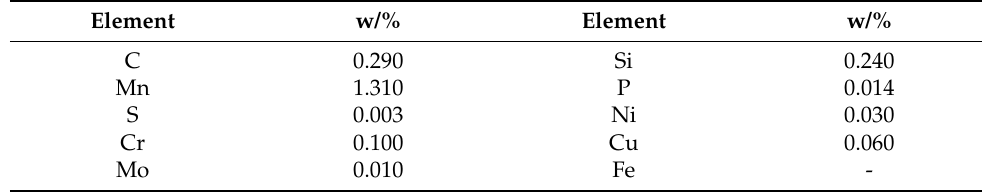
Table 2. The chemical composition of the string